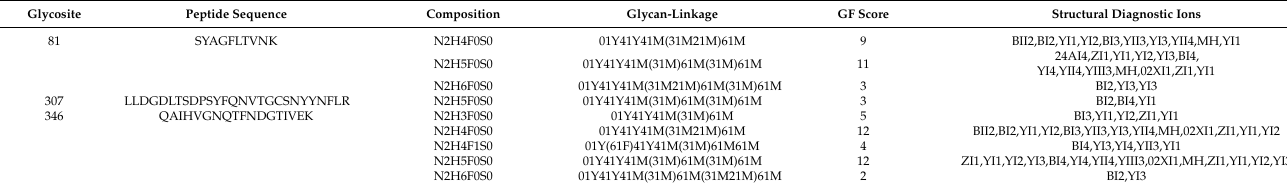
Table 1. The intact N-glycopeptides identified from probable serine carboxypeptidase CPVL (Q9H3G5, CPVL_HUMAN) modified with N2H5F0S0 on N-glycosites N81, N307 and N346 and N2H4F0S0 and N2H6F0S0 on the N-glycosite N81 and N346 as well as N2H3F0S0 and N2H4F1S0 on N-glycosite